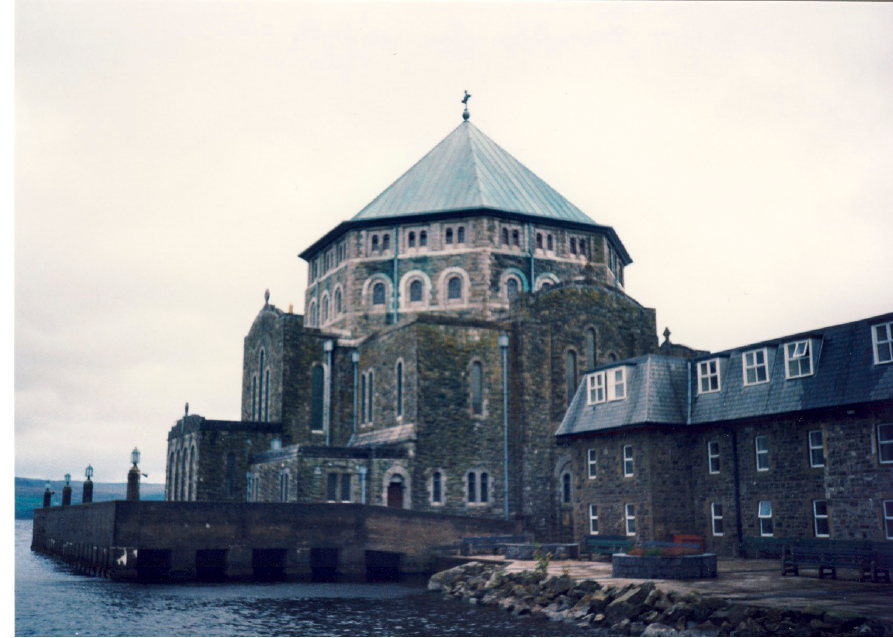
Figure 6. St. Patrick’s Basilica, Station Island, Lough Derg. Doing rounds, or encircling has its origin in pagan belief. Making a magic circle, either symbolic or real, in order to separate sacred space from profanum was commonly practiced among Indo-European peoples. It was believed that the magical power of a closed circuit protected the inner area from the outer evil powers. It also had other symbolic meaning: “the one who circumambulates takes in the power of that which is circumambulated, and vice versa” (Brenneman and Brenneman 1995, p. 34). Drawing such a circle had to be conducted in a proper way, observing proper rituals. The most important was the movement from left to right, i.e., following the sun’s daytime travel across the sky. 21 After completing a certain number of the rounds, the pilgrim drinks some water from the well using a container (a cup, a mug, a bottle), often found at the wells. At Doon Well (Co. Donegal) a set of prayers was said for every bottle of water that was taken (Ó Muirgheasa 1936, p. 156). Sometimes before drinking from the well the pilgrim performs some rituals like “throwing out three drops of water in the name of the Trinity” (Herity 1998, p. 21) at St. Columcille’s Well in Glencolumcille (Co. Donegal) (Figure 7) or lifting out water of St. Ultan’s Holy Well at Leitrim (Co. Donegal) and throwing “ against the cataract” (Ó Muirgheasa 1936, p. 161). Some cups may be votive offerings left at the well after the pilgrims drank from them. The pilgrim may also dip her/his hand in the water and bless herself/himself with it or just put some of it on her/his face or bathe the affected part of the body. Taking the water internally is the Celtic custom and applying it exter- nally is the Christian tradition (cf. Brenneman and Brenneman 1995, p. 113).